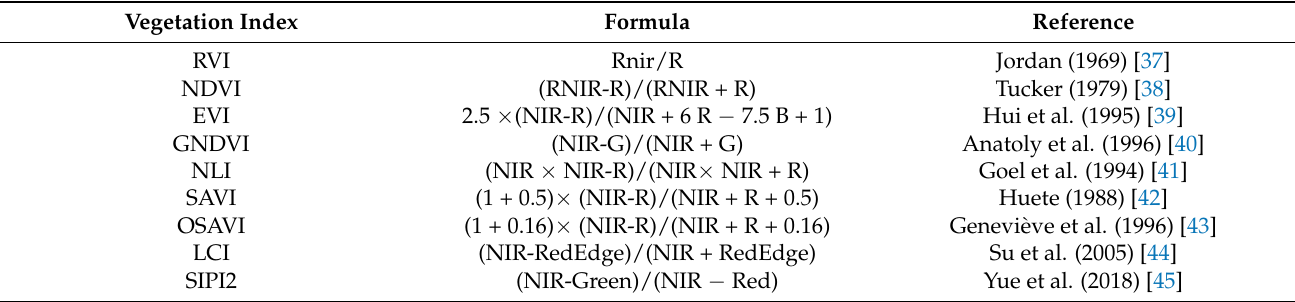
Table 3. Vegetation index and calculation